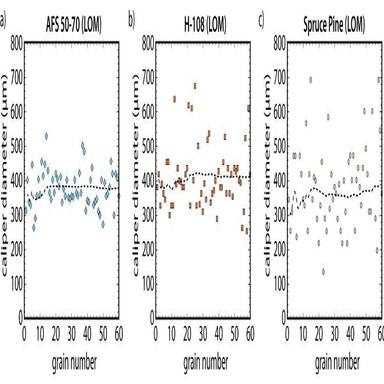
Caliper diameter and cumulative average caliper diameter up to the given number of grains (dashed lines). (a) AFS 50–70, (b) H-108, (c) Spruce Pine sand. The raw data for 60 particle measurements are also plotted for each type of sand.